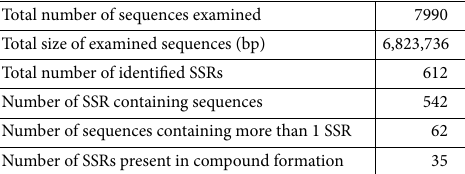
Table 4. Distribution and frequency of SSRs in the Triticum aestivum L. transcriptome.